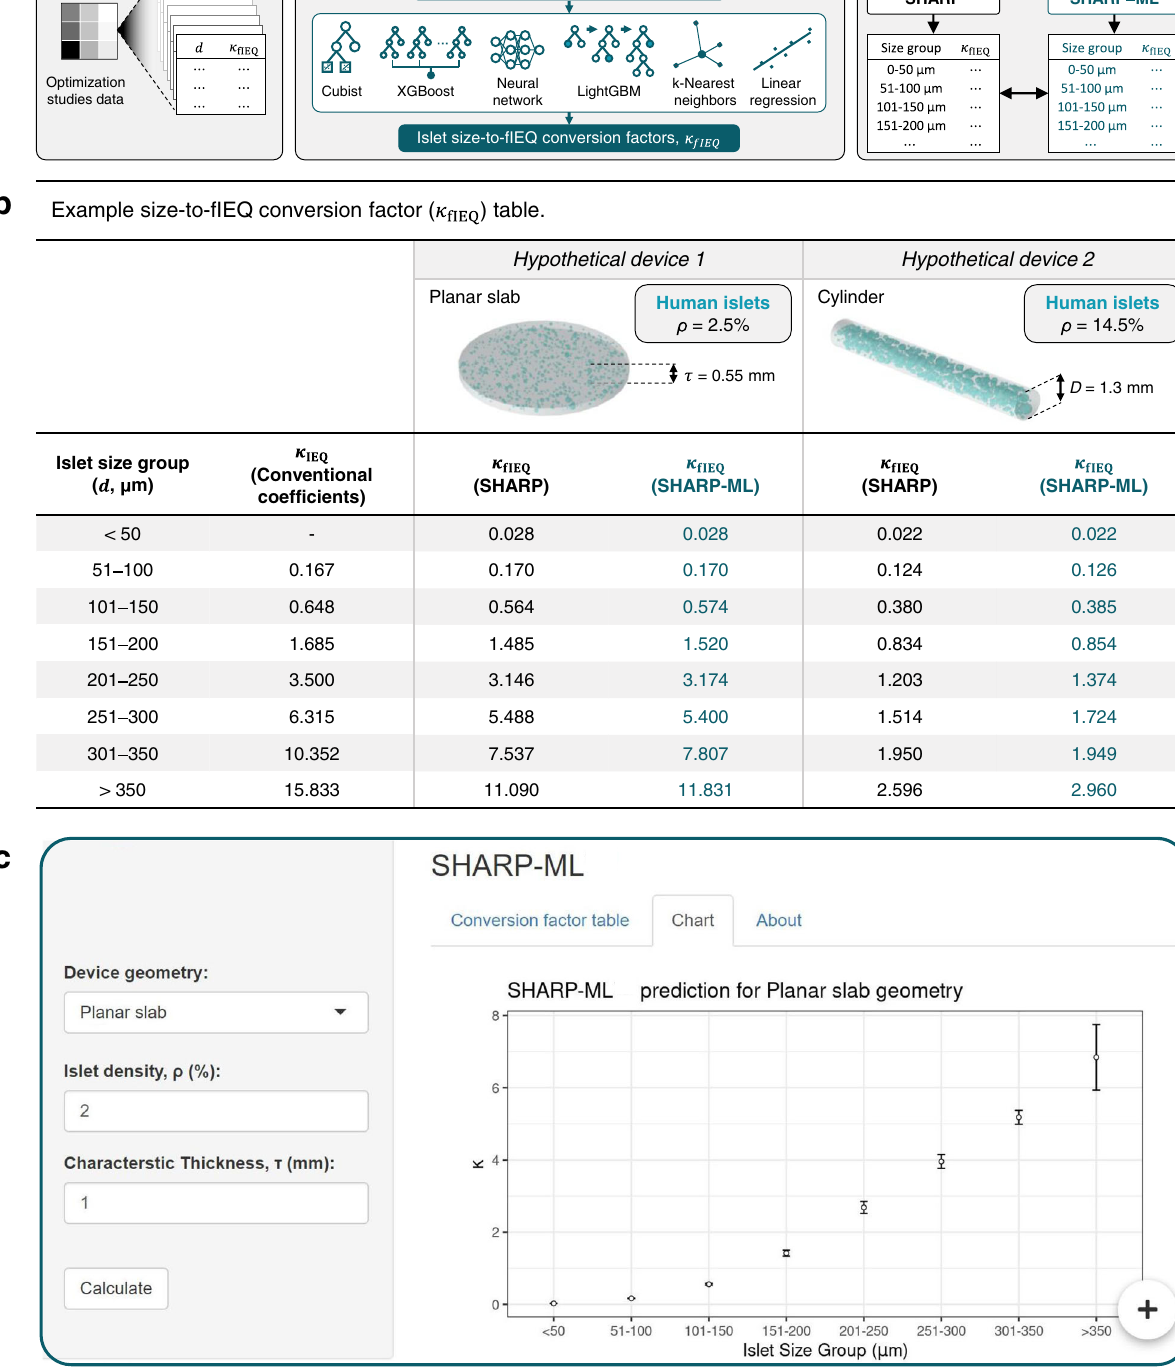
b Example islet size group-to-fIEQ conversion table for two hypothetical encap- sulation systems, showing κ fIEQ calculations by SHARP and predictions SHARP-ML. The conventional volumetric size group-to-IEQ coef fi cients, κ IEQ , are shown for comparison in the second column. c Screenshot from SHARP-ML web application ( n =18summarizedmodelpredictions):userscanoperatetheleftpaneltoindicate the device geometry and cell density, producing the κ fIEQ coef fi cients on the right panel. Data in the inset plot are presented as mean±SD ( n =18 model predictions summarized from >2×10 7 observations). Source data are provided as a Source Data fi